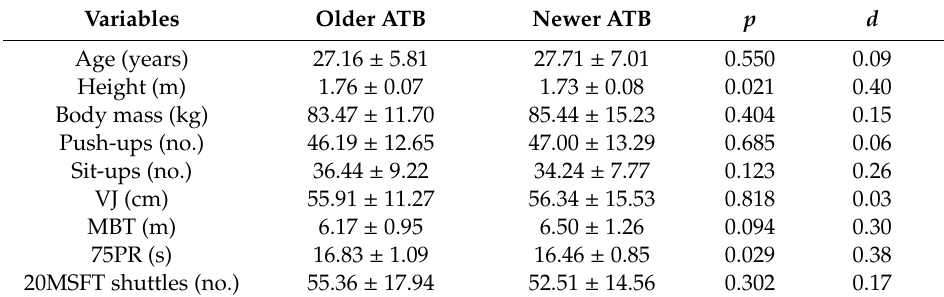
Table 2. Descriptive and fitness testing data from male recruits hired under an older ATB ( n = 442), versus one class hired under the LEA’s newer ATB ( n =